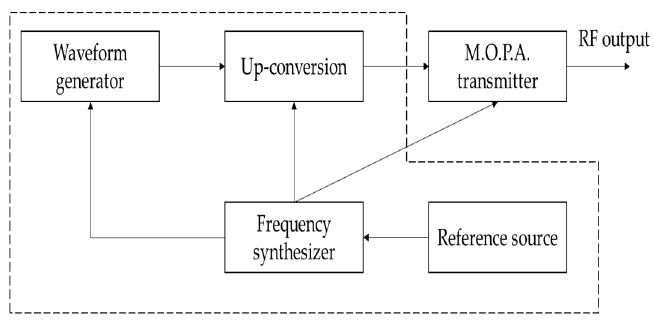
Figure 2. M.O.P.A. transmitter structure of modern coherent radar.